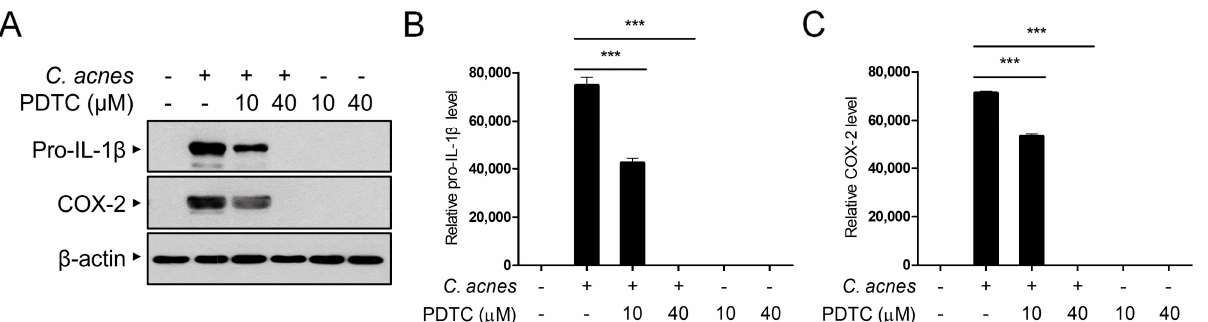
Figure 2. Inhibitory effects of PDTC on the expression of C. acnes -induced inflammatory proteins. Mouse BMDMs were pretreated with PDTC (10 and 40 µ M) for 30 min and then incubated with heat-killed C. acnes (1 × 10 6 CFU/mL) for 6 h. Pro-IL-1 β , COX-2, and β -actin protein levels were detected by Western blot analysis ( A ), and then the relative levels of protein bands were quantified ( B , C ). The results are represented as the means ± SDs of three independent experiments. *** p < 0.001.